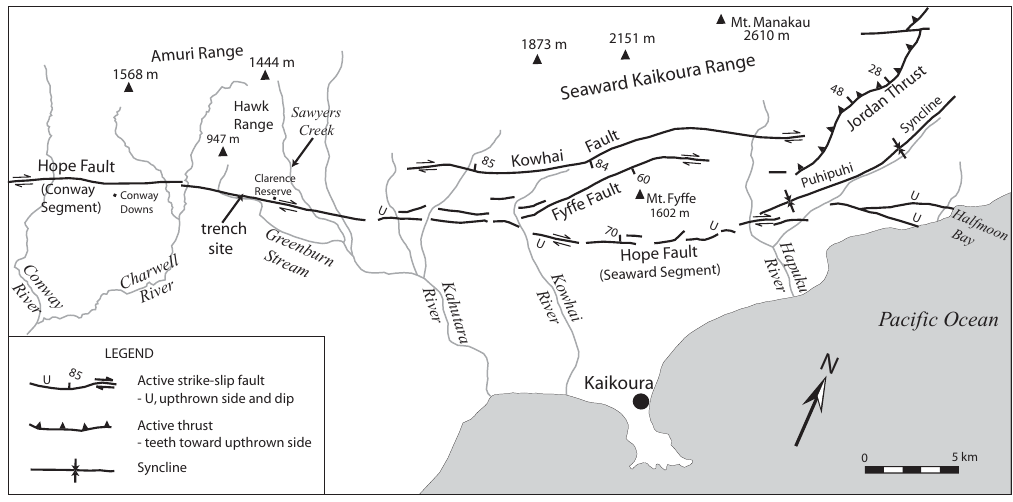
Fig. 3. Structure of the eastern Hope Fault and location of the Greenburn Stream trench site (modified after Campbell, 2001). The Conway Segment passes east into the Seaward Segment east of Kowhai River, and the Mt. Fyffe and Kowhai Faults. The trench site is adjacent to Greenburn